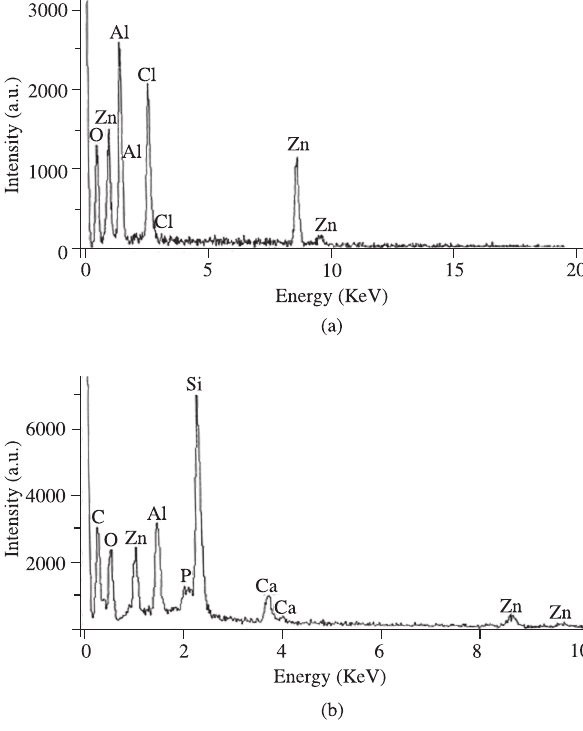
Figure 7. (a) EDS spectrum that shows the compositional energy peaks of zinc, aluminum and oxygen of the ZnAl O spectrum energy peaks of calcium and phosphorus elements of the mineral- 2 4 like tissue deposited by osteoblasts cells cultured onto ZnAl 5 days of